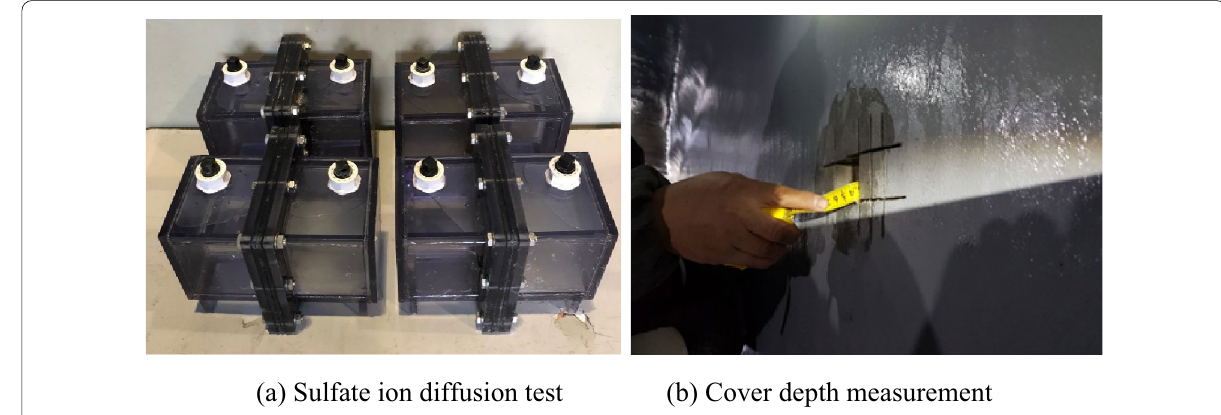
Fig. 4 Evaluation of random variable of diffusion coefficient and cover depth.